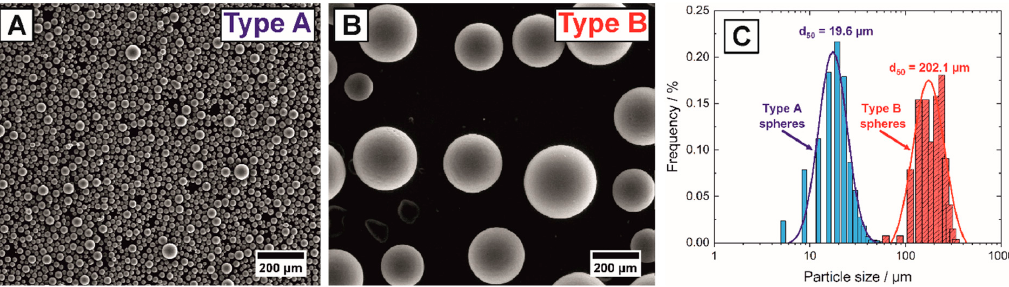
Figure 1. Microstructure ( A , B ) and particle size distributions ( C ) of the type A (d 50 = 20 µm) and type B (d 50 = 200 µm) phenolic resin spheres utilized as spherical pore formers.